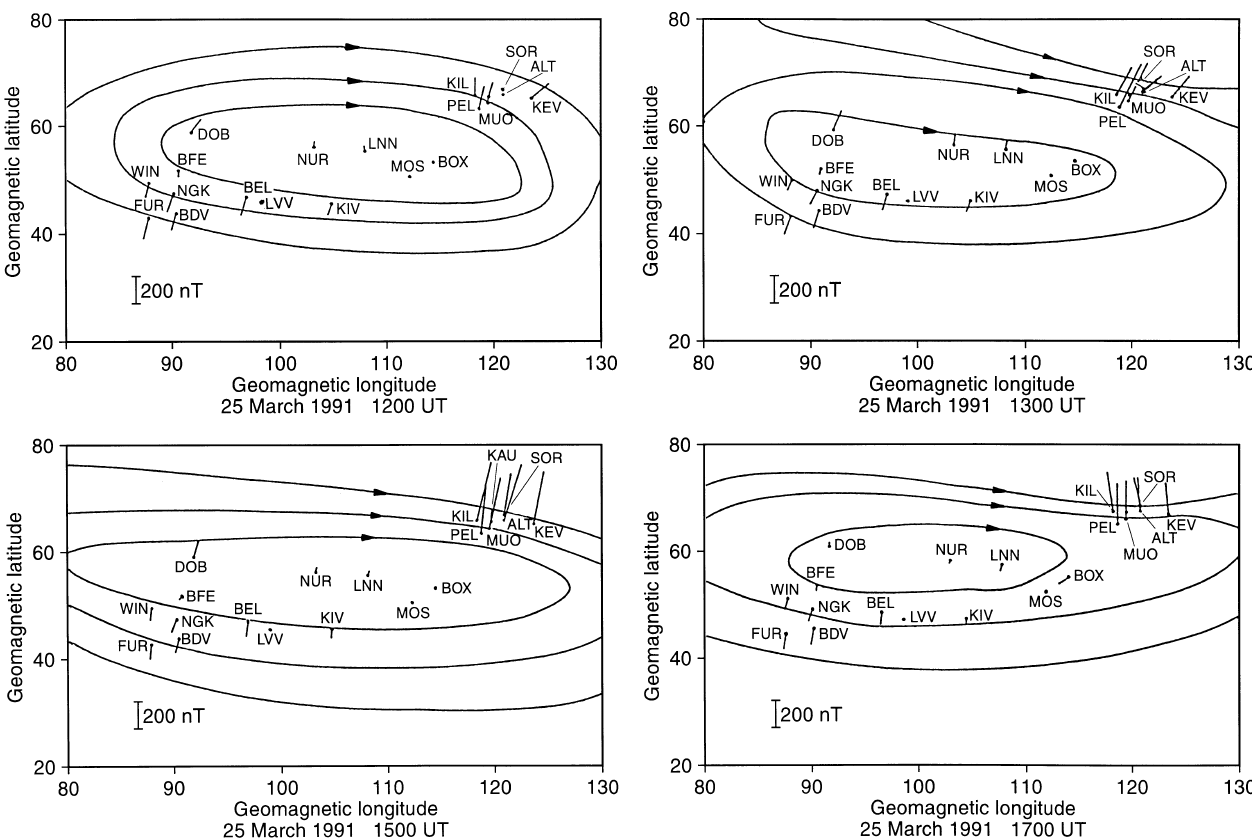
Fig. 12. Horizontal magnetic disturbance vectors and the equivalent ionospheric current system, respectively, for di(cid:128)erent time moments on 25 March 1991